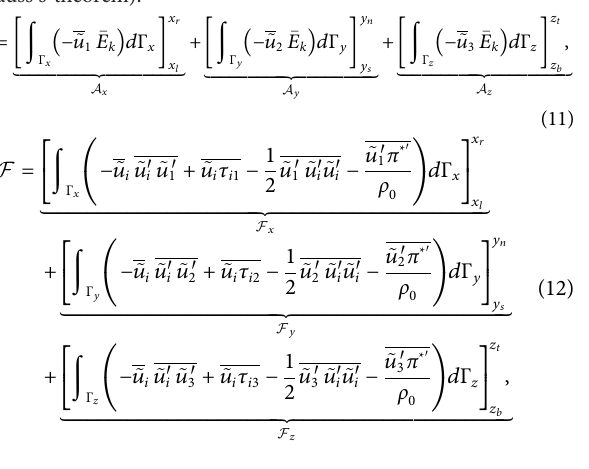
velocity gradients are underestimated, because they are calculated with central differences. Second, the fi fth order upwind advection scheme of Wicker and Skamarock (2002) has numerical dissipation, suppressing the magnitude of the smallest eddies, for which the gradients and the dissipation are highest (Maronga et al., 2013). The positive residual is subtracted from the negative dissipation term D to compensate for the underestimated magnitude of the calculated dissipation.